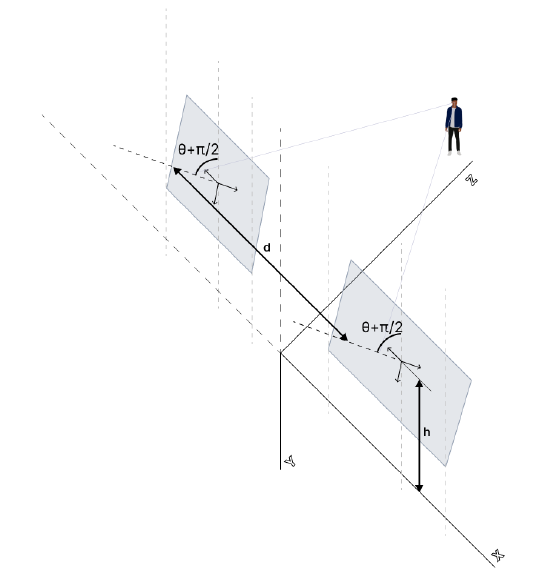
Figure 1. Schematic representation of a stereo vision